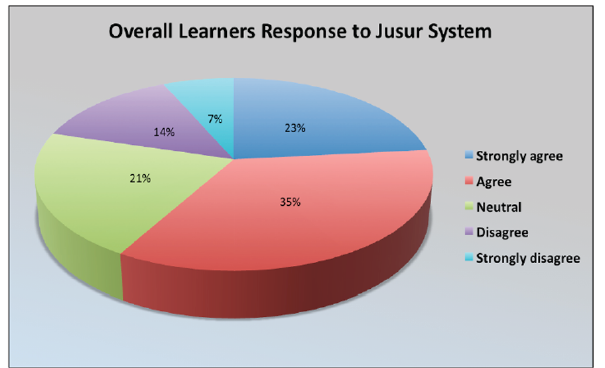
Figure 2. Overall